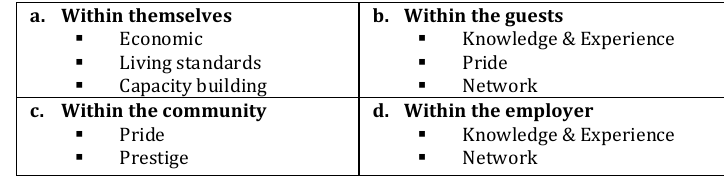
Table 2 Advantages among local people who participate in the Me sastila Resort and Spa’s